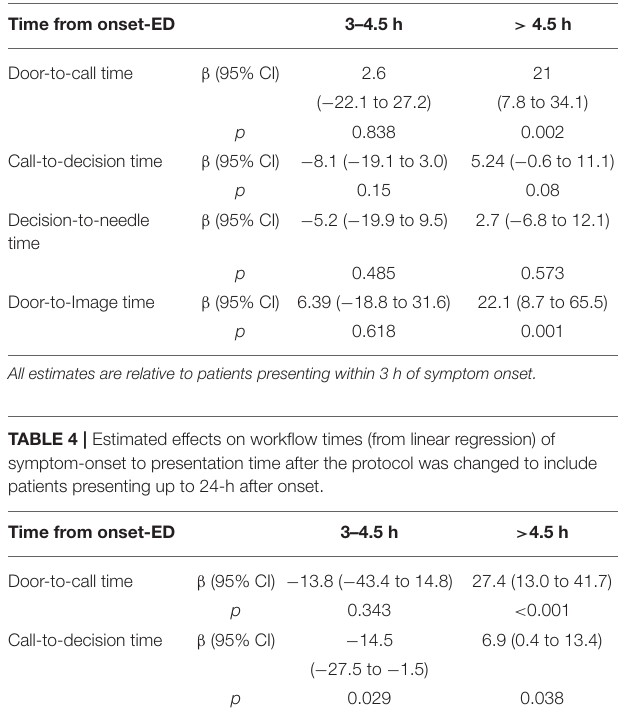
TABLE 3 | Estimated effects on workflow times (from linear regression) of symptom-onset to presentation time for all patients. Time from onset-ED